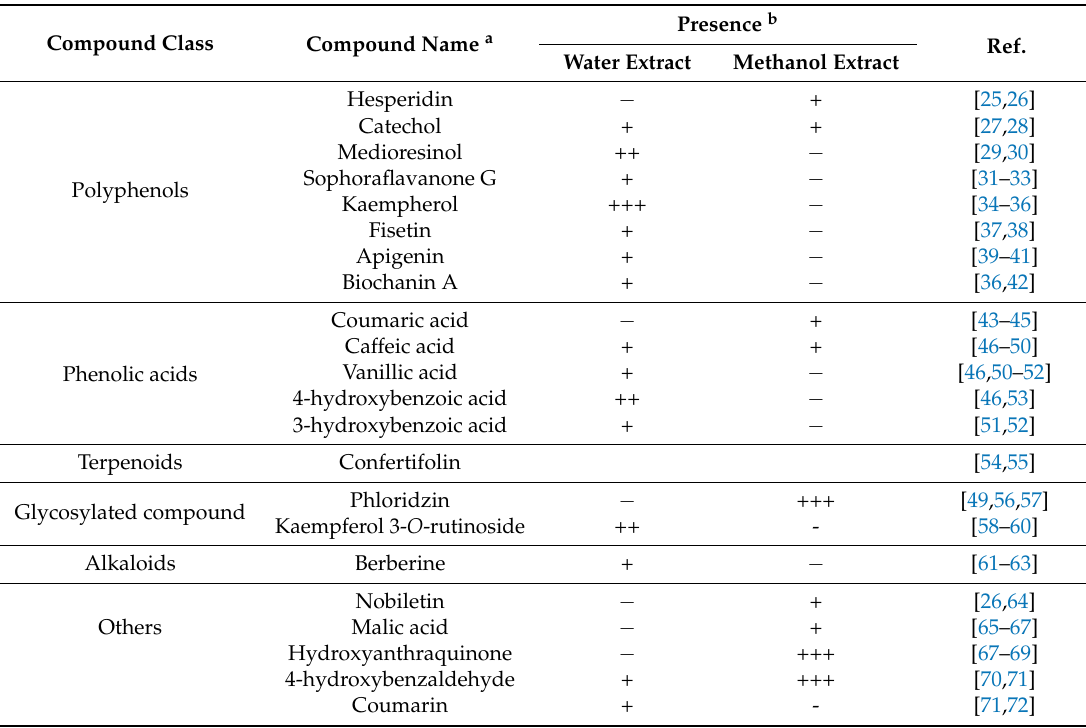
Table 4. Examples of compounds with known antimicrobial properties identified in Quaking Aspen bark